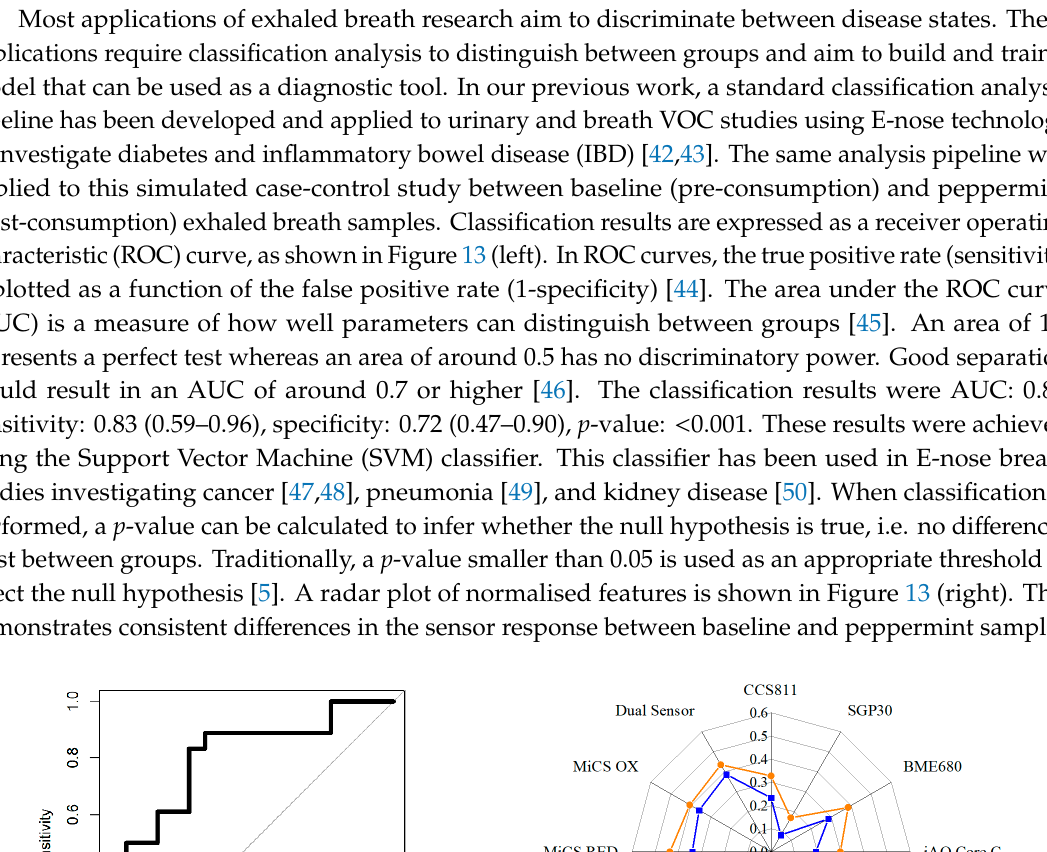
Figure 12. Typical output response to exhaled breath.